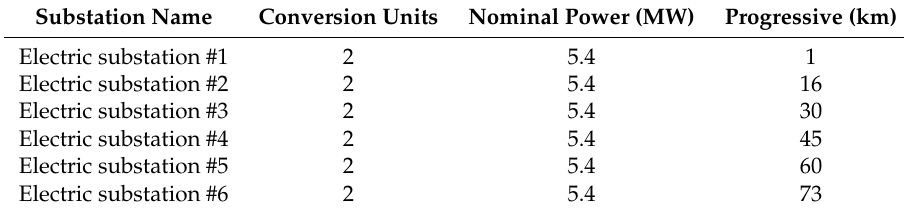
Table 5. Substations on the